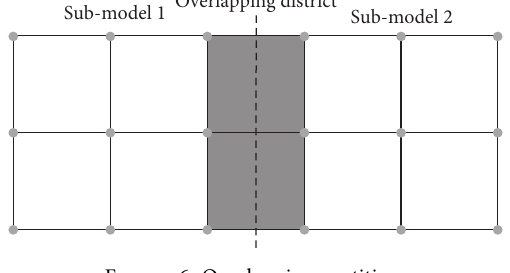
Figure 6: Overlapping partition.